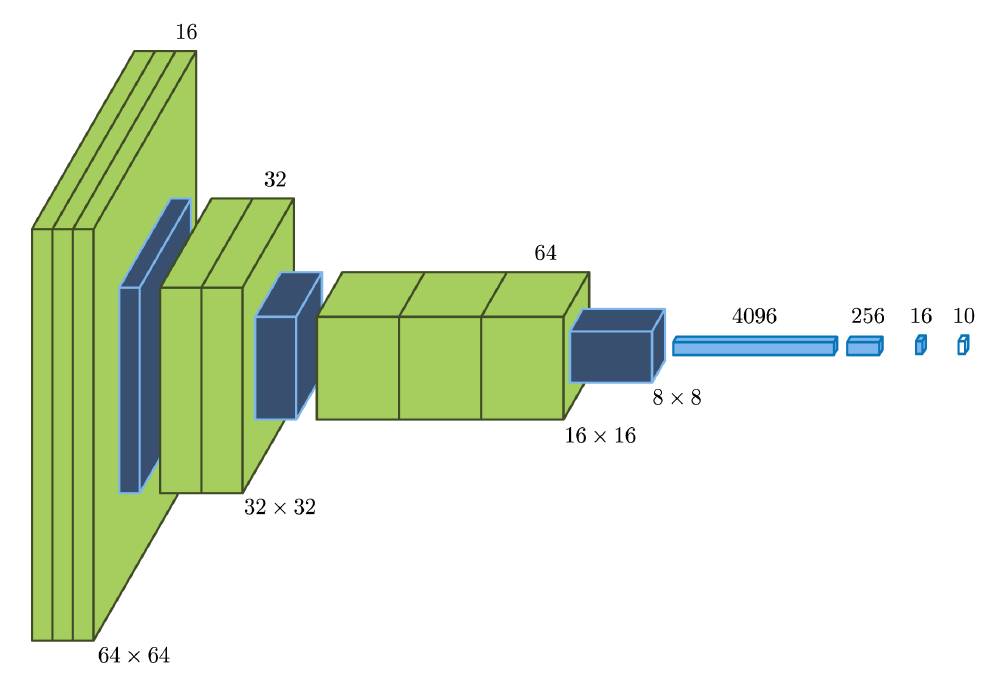
Figure 8. Neural network architecture for the first